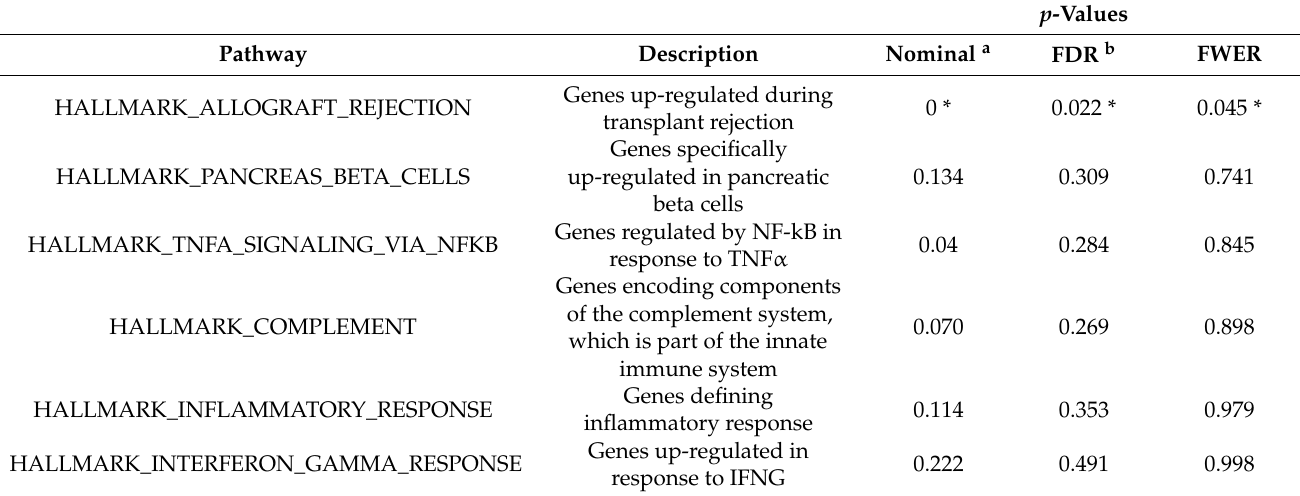
Table 1. Functional pathways enriched in VS tumor tissue from patients with tinnitus compared with those without tinnitus according to GSEA.